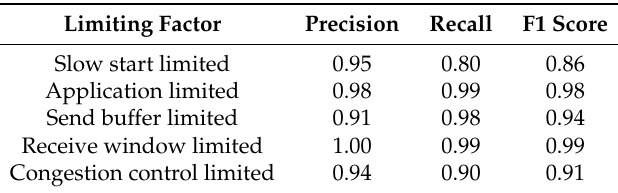
Table 3. EVA’s performance for different limiting factors.